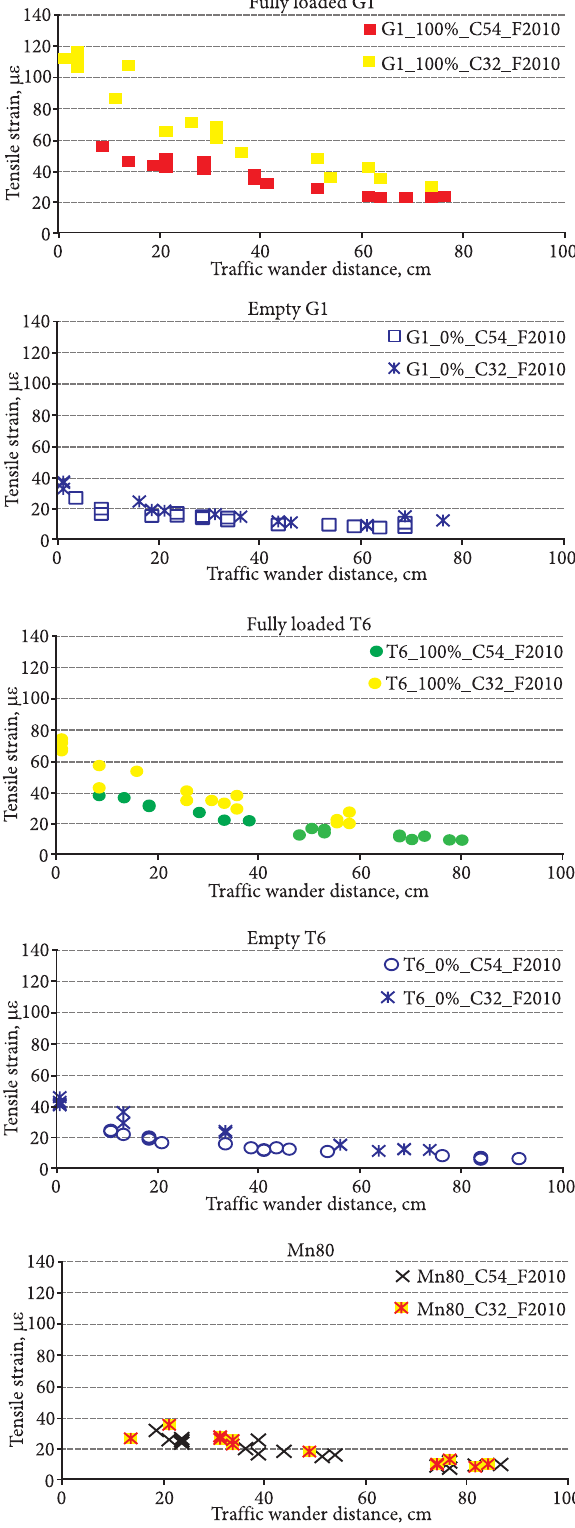
Fig. 9. Effect of PCC pavement structure on tensile strains at the bottom of the PCC slab near mid-slab